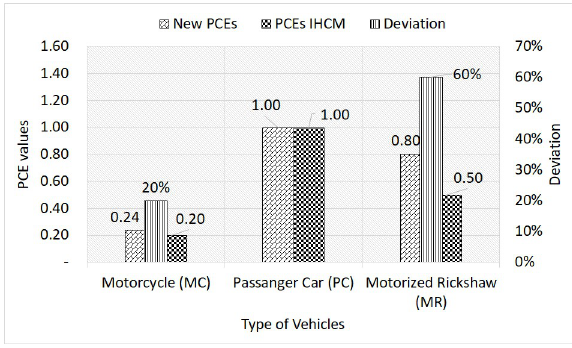
Fig 5. Validation result between new PCEs and PCEs from